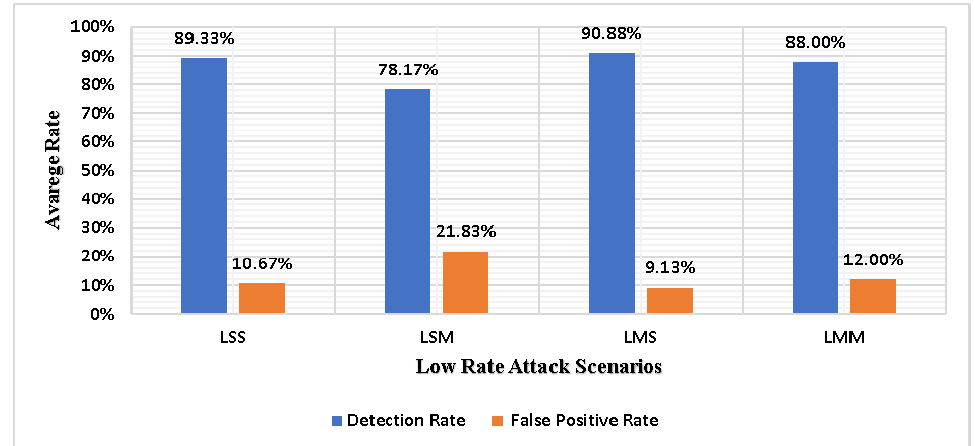
Figure 3. Average DRs and FPRs using low-rate attack scenarios in 30 min.